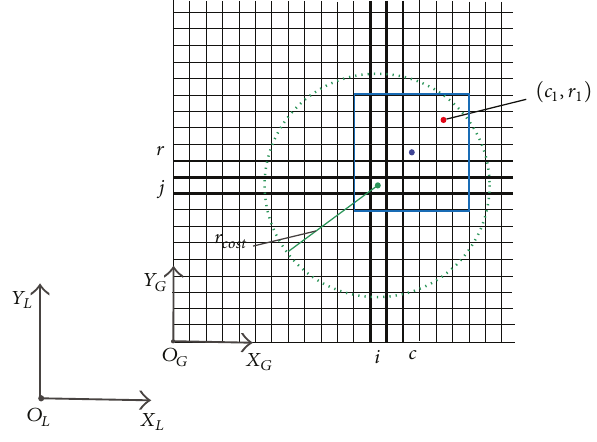
Figure 1: 2D projection of grid based elevation